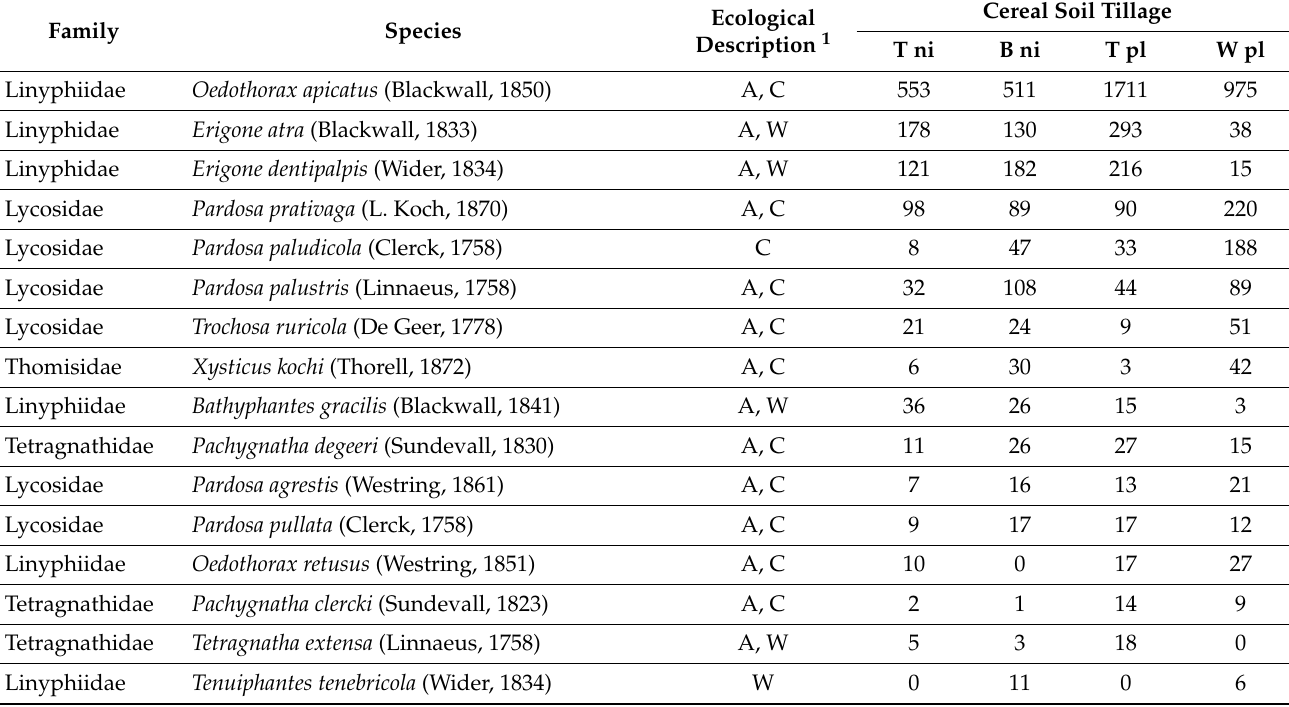
Table 2. Species composition, abundance, and indices describing ground-dwelling spiders occurring in cereals (T-triticale, B-barley, W-wheat) cultivated in ploughing (pl) and non-inversion (ni) tillage system. Family Species